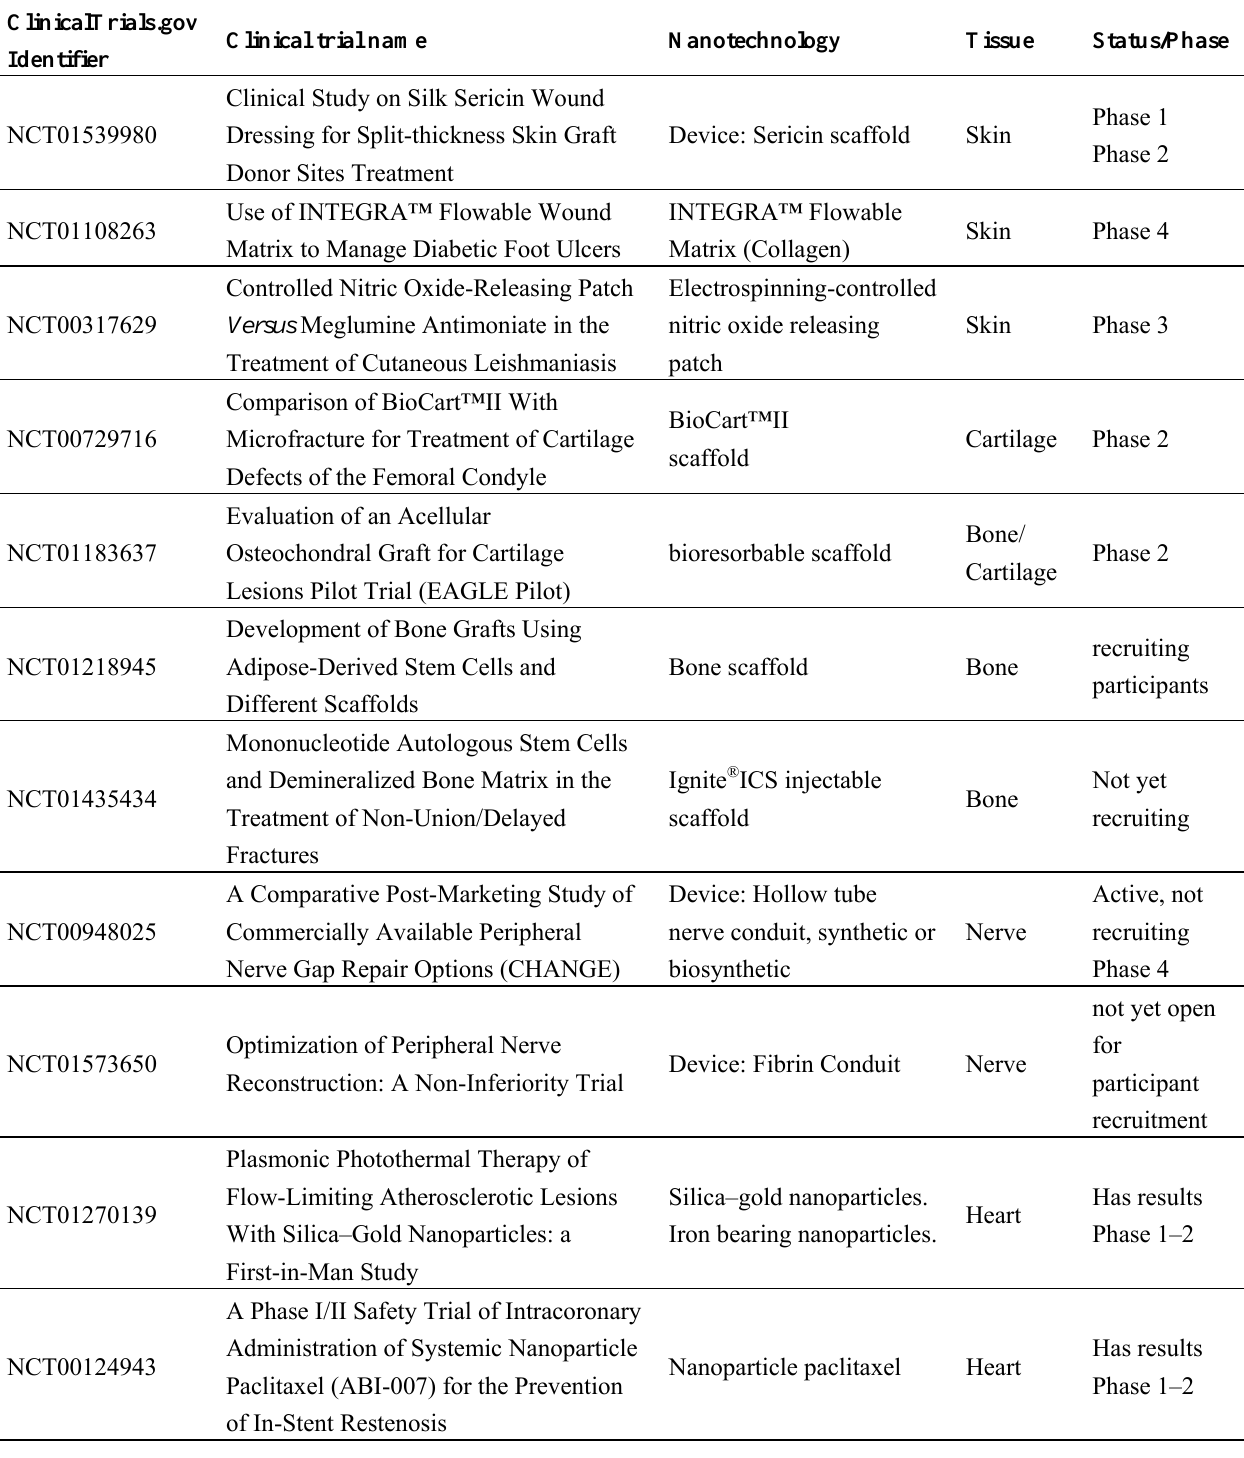
Table 1. Clinical trials on the use of nanotechnological devices for tissue regeneration.